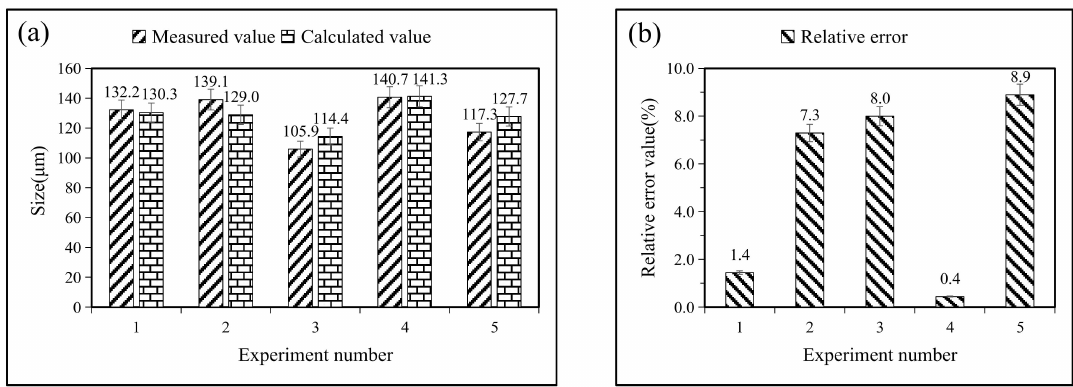
Figure 10. Error verification of Equation (6) (( a ). comparison of measureed value and calculated value; ( b ). corresponding relative error).